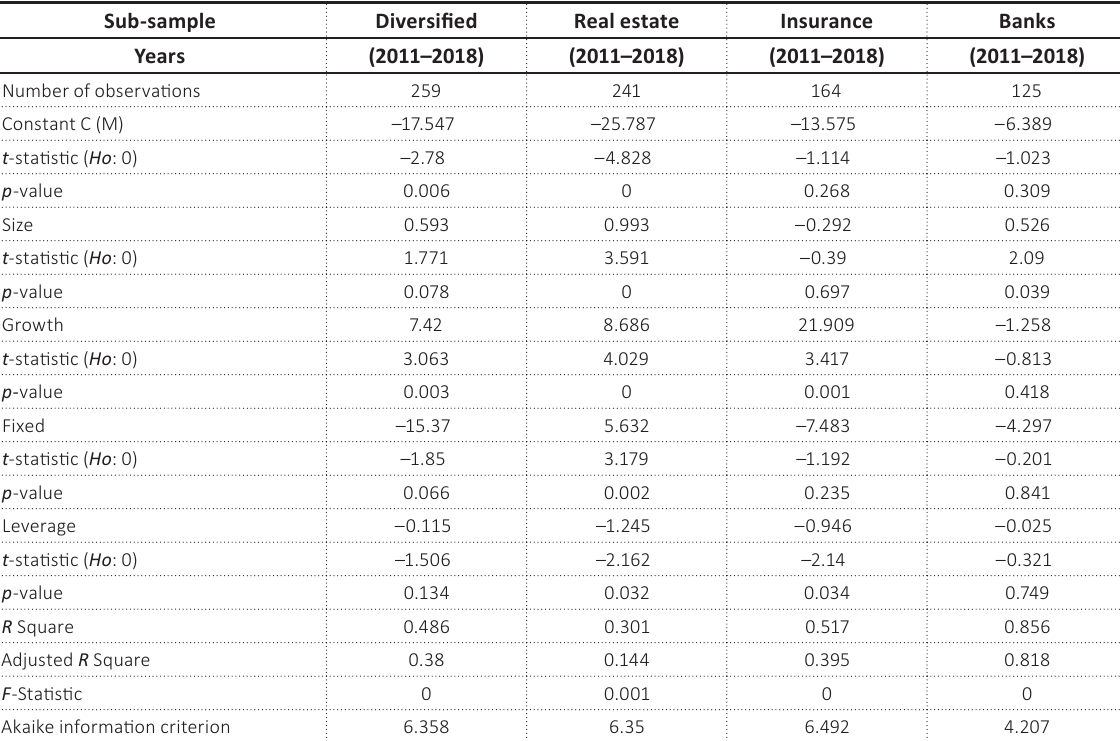
Table 7 shows the regression analysis results for the financial sector sub-samples. Table 7. Regression analysis for the financial